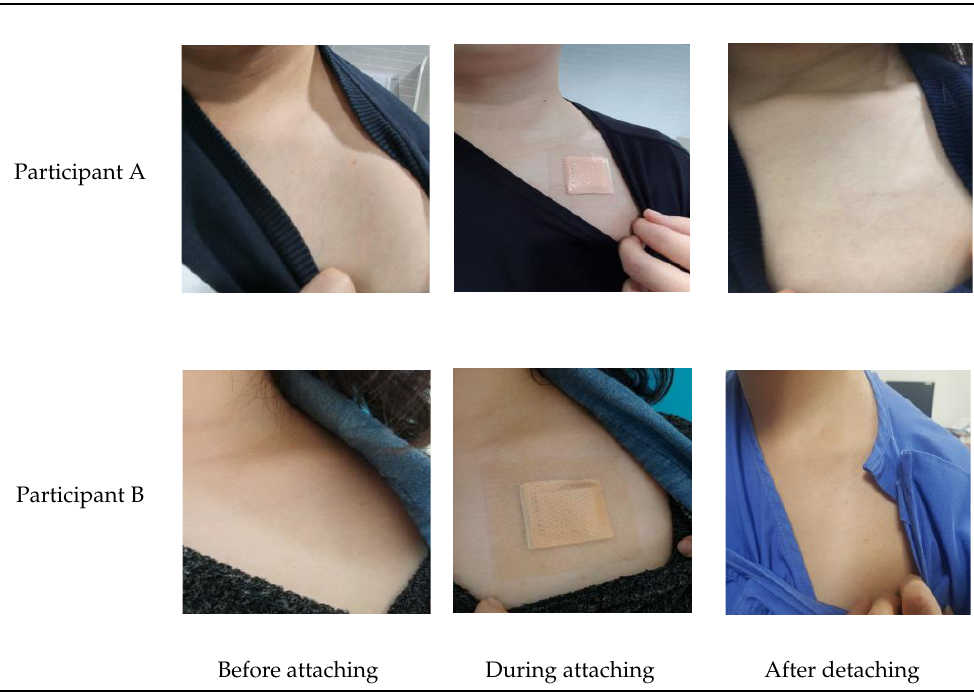
Figure A1. The red line means the body temperature measured by the infrared forehead thermometer; the blue line means the body temperature measured by the smart patch. The fifth graph at the first line is the dropout participant, missing information in spite of the 24-h attachment of the smart patch.